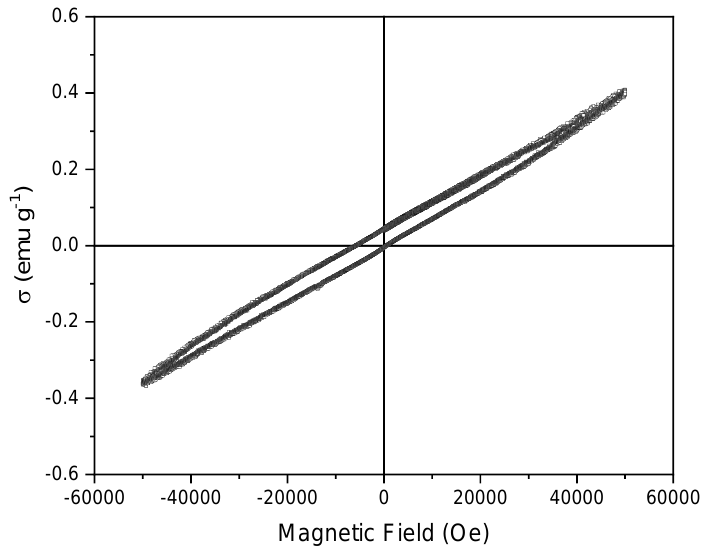
Figure 8. Magnetic hysteresis loop of the resulting LaFeO 3 pellet obtained after the reaction flash sintering process.